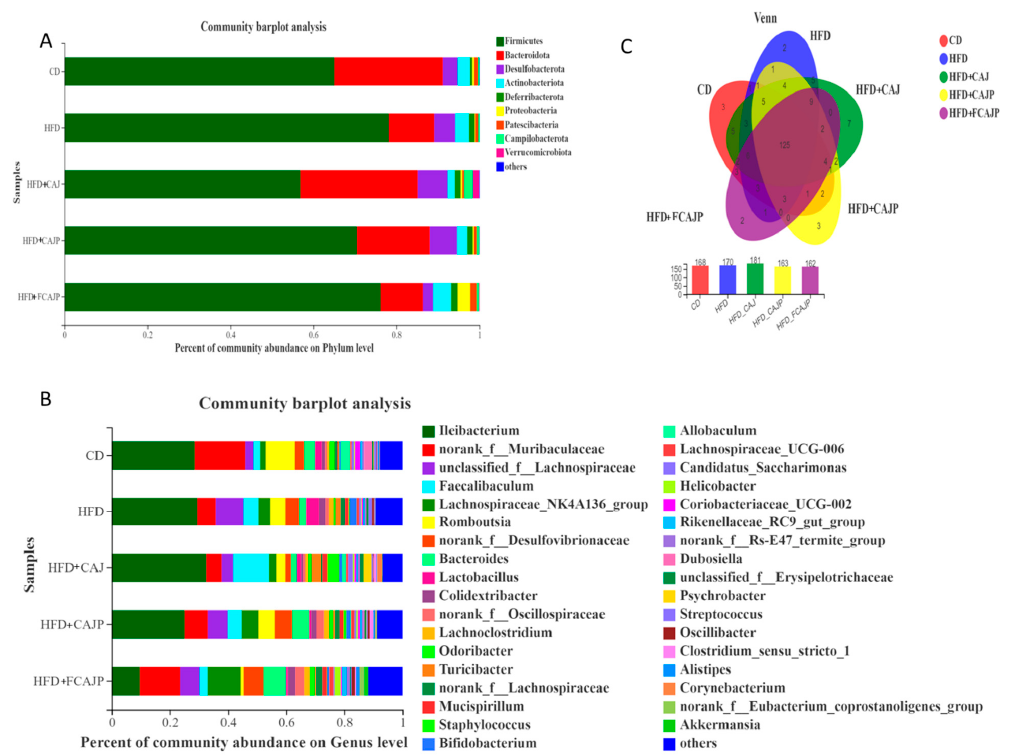
Figure 4. Responses of the diversity, richness, and structure of the gut microbiota ( n = 8). ( A , B ) Relative abundances of the gut microbiota at the phylum level and genus level; ( C ) Venn diagram analysis at genus level. Note: CD: basal diet & Saline; HFD: 45% high-fat diet & Saline; HFD + CAJ: 45% high-fat diet & CAJ; HFD + CAJP: 45% high-fat diet & CAJP; HFD + FCAJP: 45% high-fat diet &